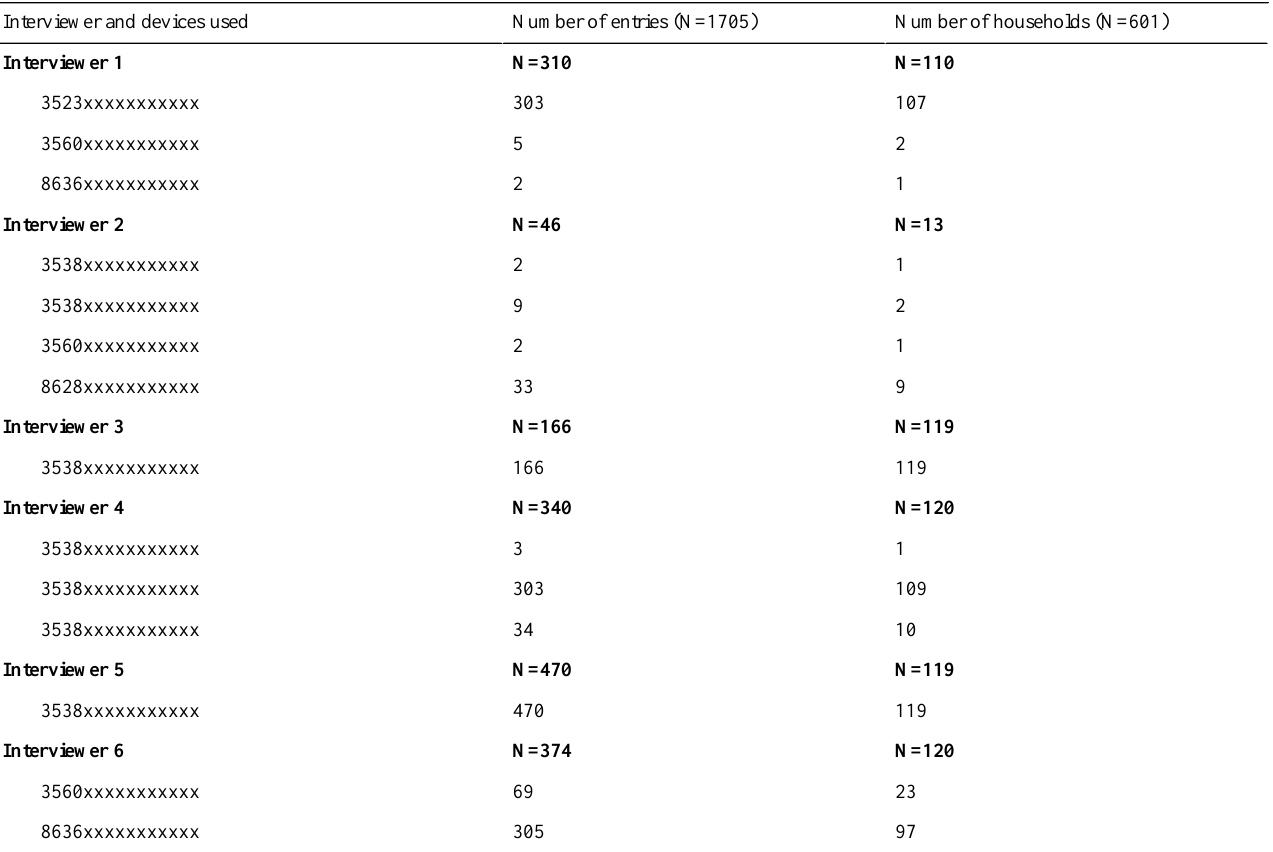
Table 2. Devices used by data collectors, number of households, and data entries made.